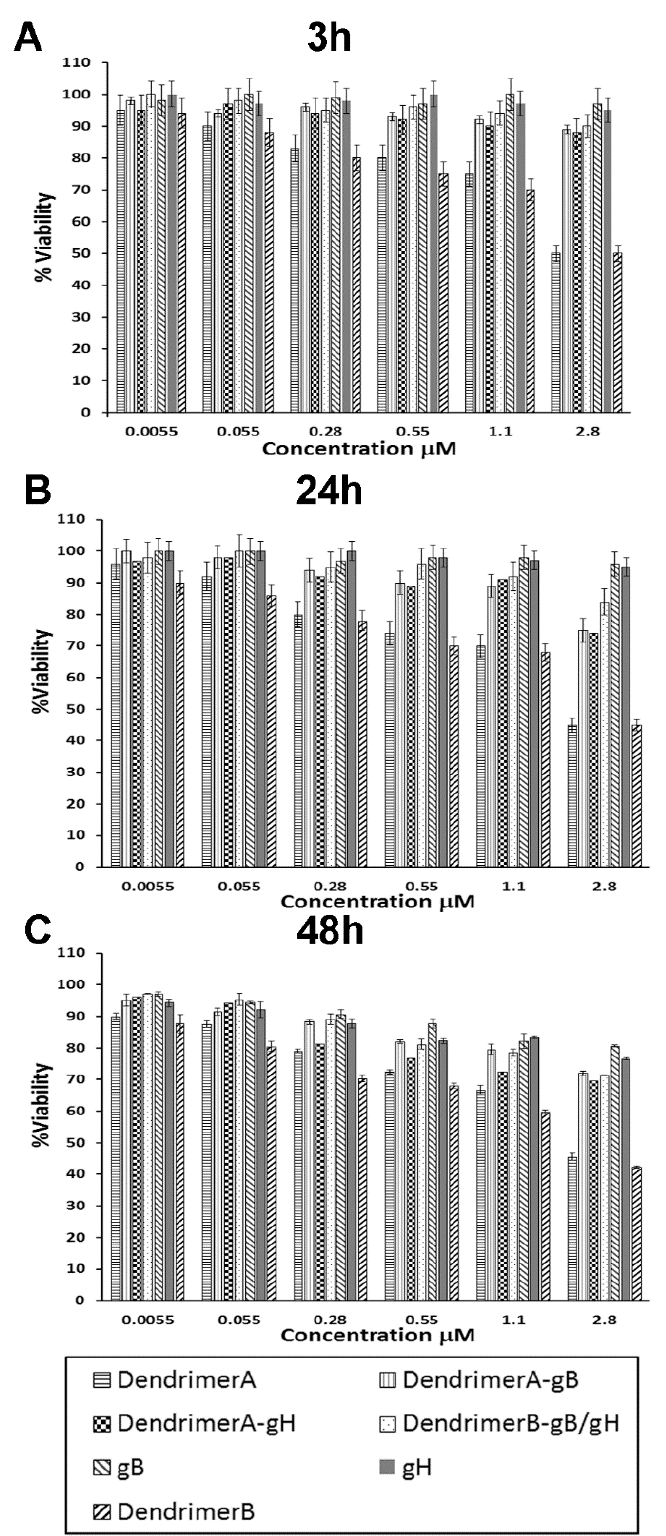
Figure 4. Cytotoxicity experiments performed after 3 h (panel A ), after 24 h (panel B ) and after 48 h (panel C ). Experiments were performed in triplicate, and the percentages of viability were calculated with respect to no-compound control experiments. Error bars represent standard deviations.